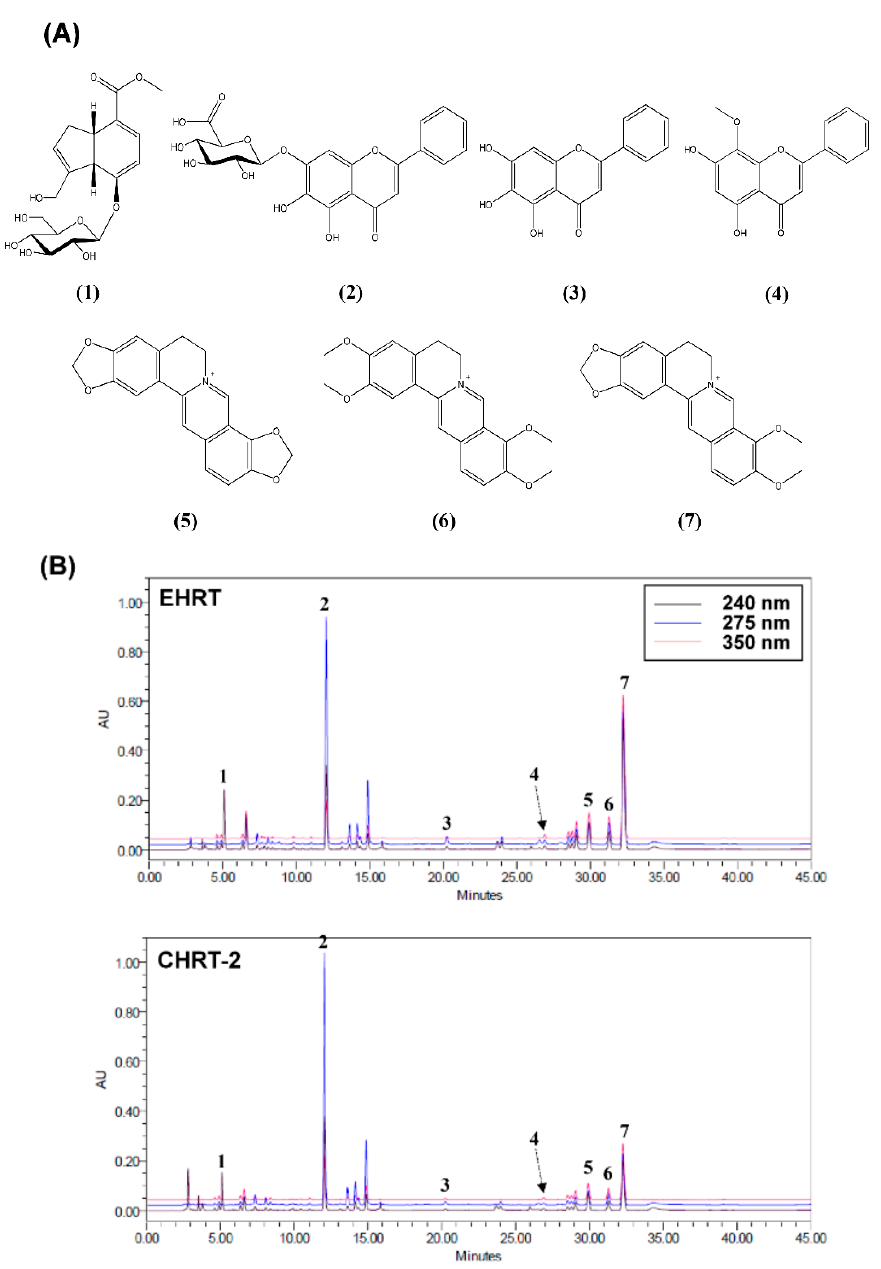
Figure 6. Chemical structures of the seven standard compounds ( A ) and HPLC chromatograms of HRT formulations ( B ). Simultaneous quantification of EHRT (2 mg/mL) and CHRT-2 (10 mg/mL) was conducted at 240, 275, and 350 nm. 1: geniposide, 2: baicalin, 3: baicalein, 4: wogonin, 5: coptisine, 6: palmatine, and 7: berberine.